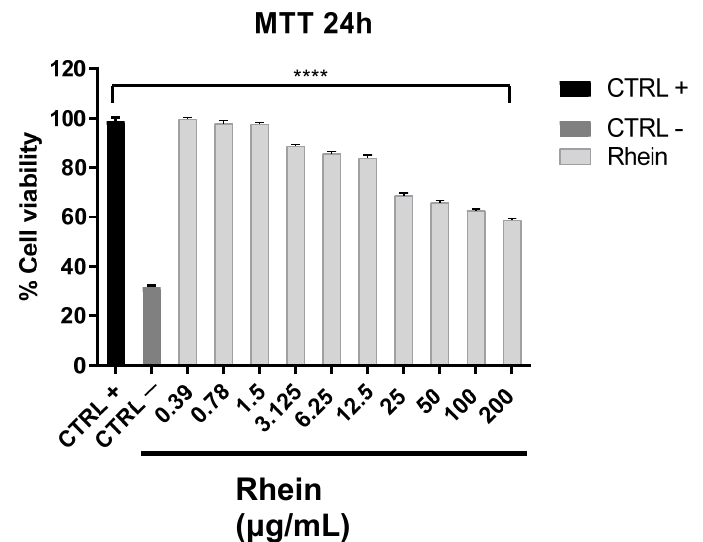
Figure 1. Cytotoxicity of rhein on Vero cells. Cells were treated with rhein and MTT assay was carried out after 24 h. The values are the mean ± SD of three independent experiments. The levels of statistical significance are indicated as follows: **** p < 0.0001. CTRL+: untreated cells; CTRL − : DMSO-treated cells.